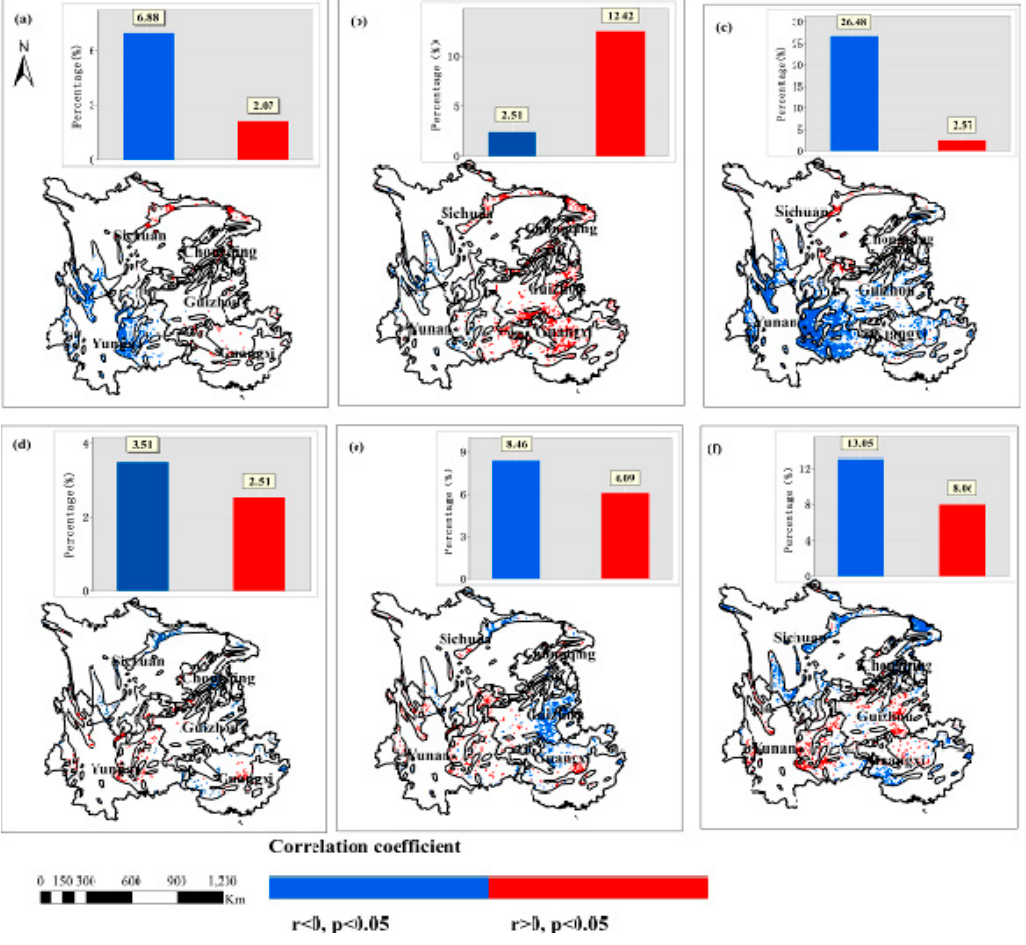
Figure 5. Significant correlation between temperature and NDVI in 1982–2015 ( a ), before the breakpoint ( b ), after the breakpoint ( c ); correlation between precipitation and NDVI in 1982–2015 ( d ), before the breakpoint ( e ), after the breakpoint ( f ). The insets show the frequency distribution of corresponding values.